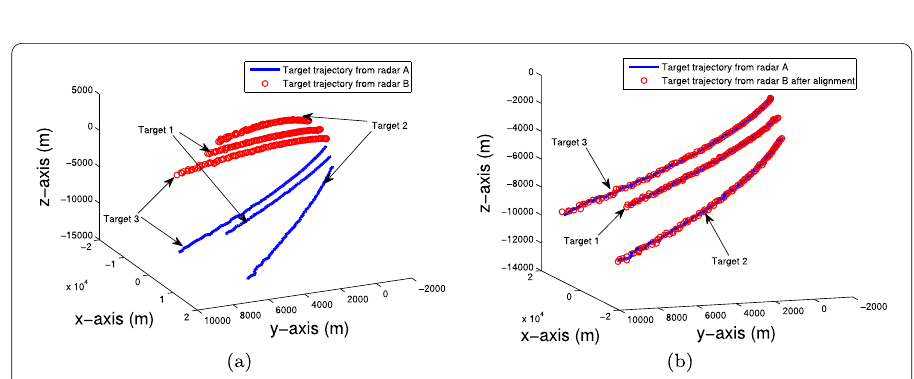
Fig. 13 Multi-target trajectories from radars A and B a before alignment b after